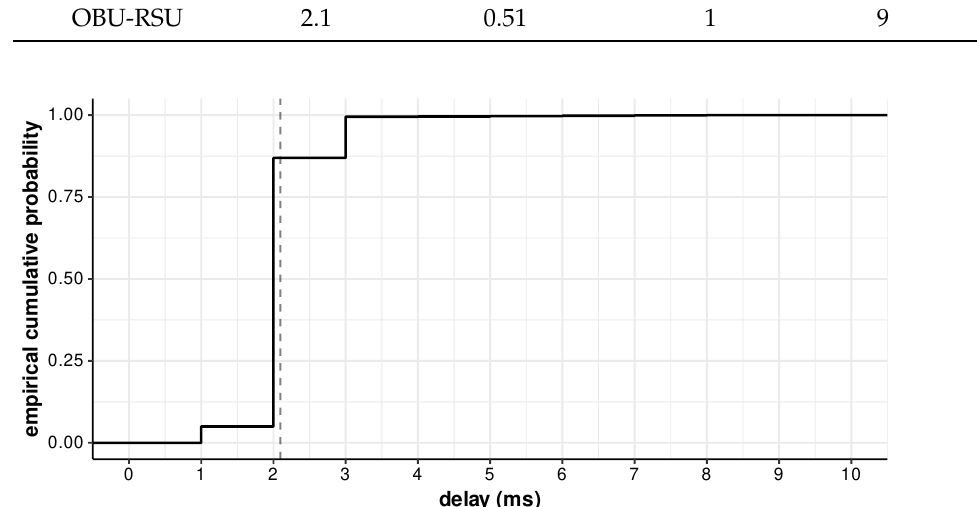
Table 4. OBU (Access layer) to RSU (Access layer) delay results in milliseconds for packets with no processing associated. Mean Std. Dev. Min. Max.